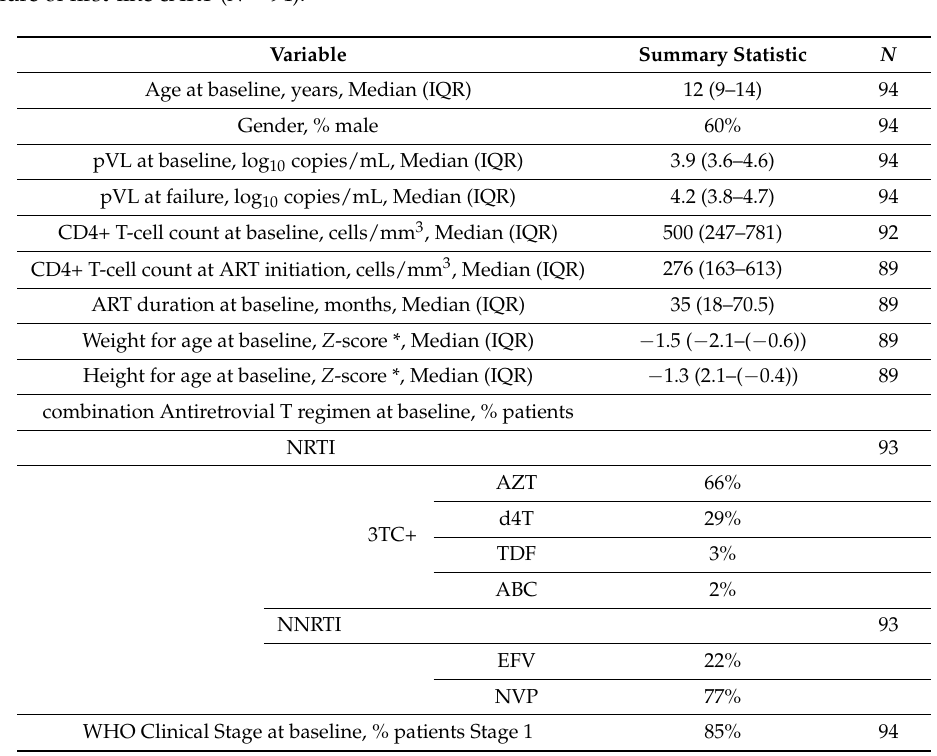
Table 1. Clinical and sociodemographic characteristics of EPHIC participants experiencing virologic failure of first-line cART ( N =